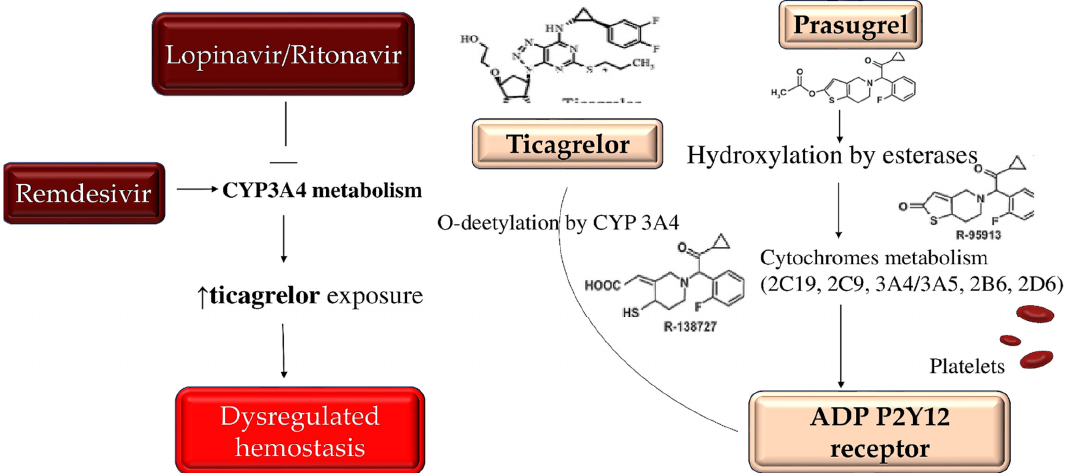
Figure 5. Depiction of the interaction between antiviral medicaments and antiplatelet drugs on CYP3A4 metabolism. In the marked red box, antiviral agents are represented. Lopinavir and ritonavir drive an inhibitory action on the cytochrome. This activity may increase the exposure of ticagrelor (marked yellow box), leading to a dysregulation of hemostasis (highlighted in the picture being the only depicted potential effect). Conversely, remdesivir (marked red box) is an inducer of CYP3A4 function. Differently from ticagrelor, prasugrel (marked yellow box) is metabolized by several cytochromes (2C19, 2C9, 3A4/3A5, 2B6, and 2D6), thus its effects seem to be unmodified by ritonavir or lopinavir interaction. Abbreviations: CYP3A4: cytochrome P450 3A4, ADP P2Y12 receptor: adenosine 5 (cid:48) diphosphate P2Y12